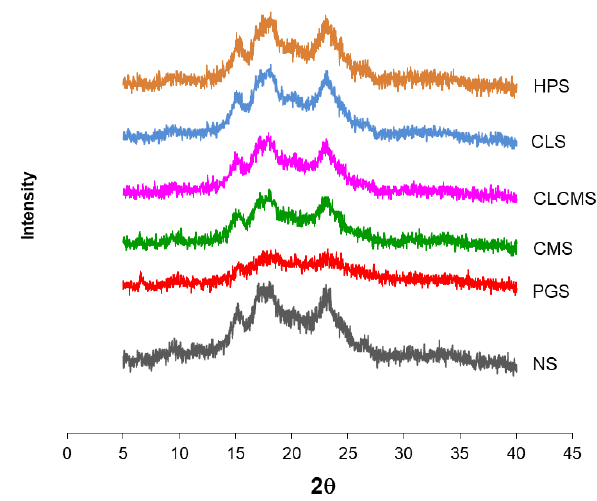
Figure 4. XRD Profiles of Native and Modified KJ CMU-107 Starches.